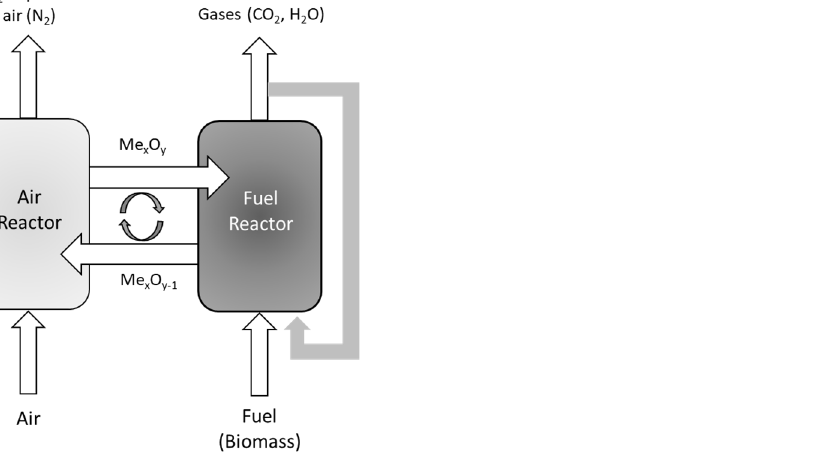
Figure 1. The simplified main principle of chemical-looping combustion. Two designated reactors where oxygen carrier is respectively oxidized and reduced.